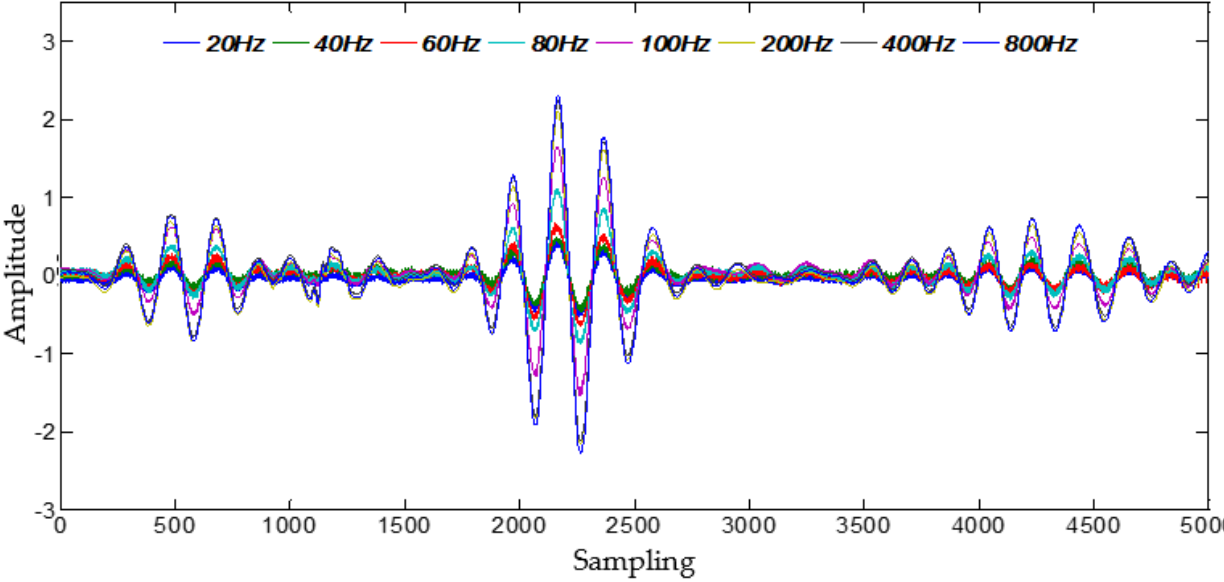
Figure 7. Comparison of PZT 1 sensor signals with vibration at different Hz frequency.